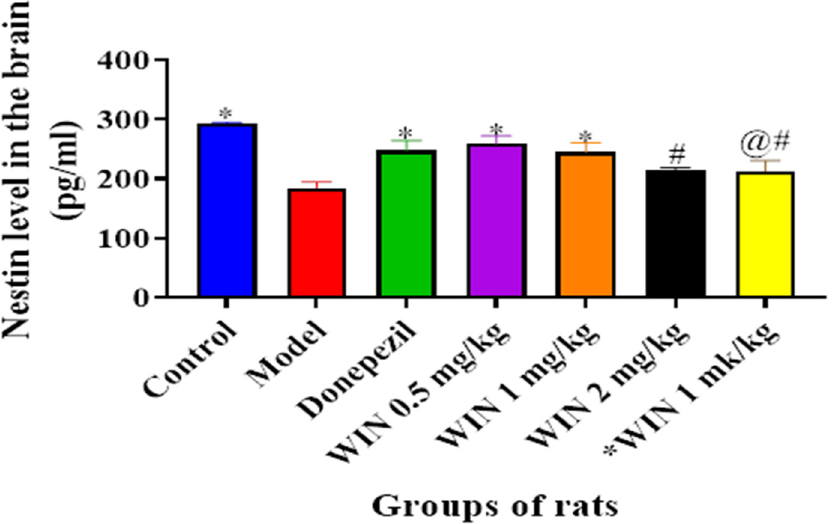
Figure 9. Effects of WIN on Nestin levels in the brain of D -gal- and AlCl 3 -induced rats. Value are shown as mean ± SEM, n = 5. * p < 0.05 vs. model group, # p < 0.05 vs. control and @# p < 0.05 vs. donepezil group.